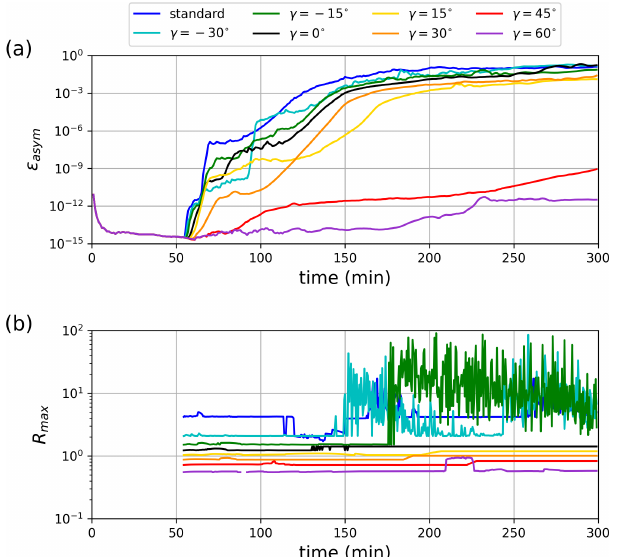
Figure 6. (a) Time evolution of the asymmetry factor (cid:15) asym and (b) time series of the maximum error amplification ratio R max , in a sensitivity experiment on the stress correction path angle γ , using the generalized stress correction scheme.